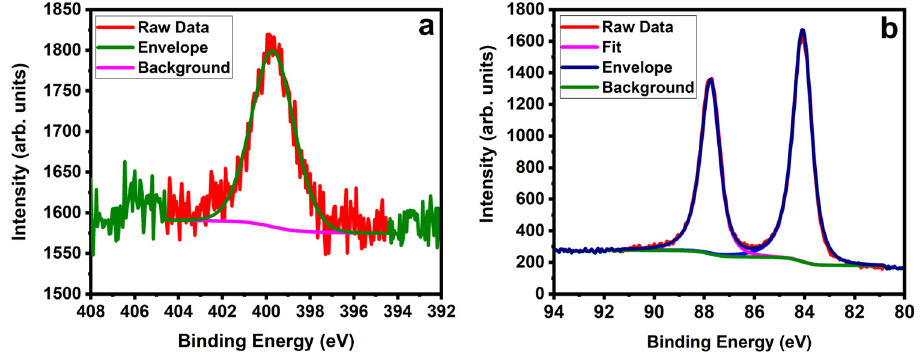
Figure 6. (a) High-resolution XPS spectra of N 1s after azidization. (b) High-resolution XPS spectra of Au 4f 7 / 2 and Au 4f 5 / 2 after AuNPs functionalization of the SWNTs. TEM was used for the structural characterization of the gold-functionalized